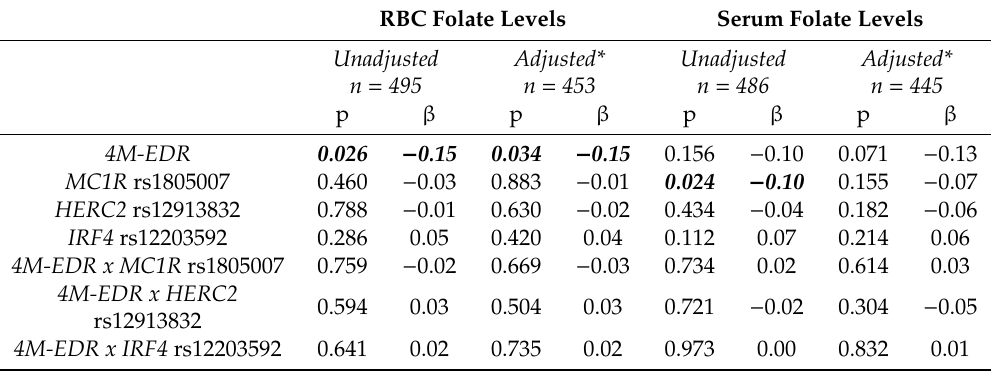
Table 8. Interactions between 4M-EDR and skin pigmentation variants in predicting folate levels. RBC Folate